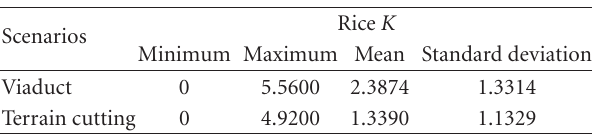
Figure 4: Sample empirical CDF of the small scale signal envelope and theoretical model fits for terrain cutting scenario. The Rice K factor is 1.43 and Nakagami parameter m is 1.59. Table 3: Rice K